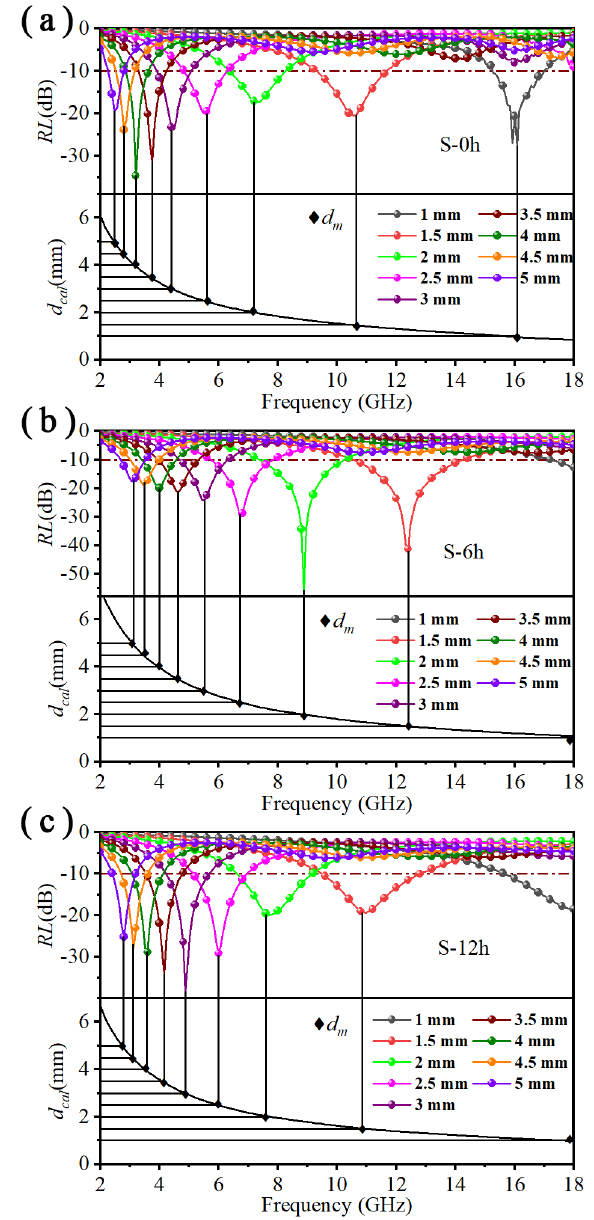
Figure 6. RL − f curves and the corresponding d m − f and d cal − f ( n = 1) curves of NiCoMnSn alloy flakes: ( a ) S-0h, ( b ) S-6h, and ( c )